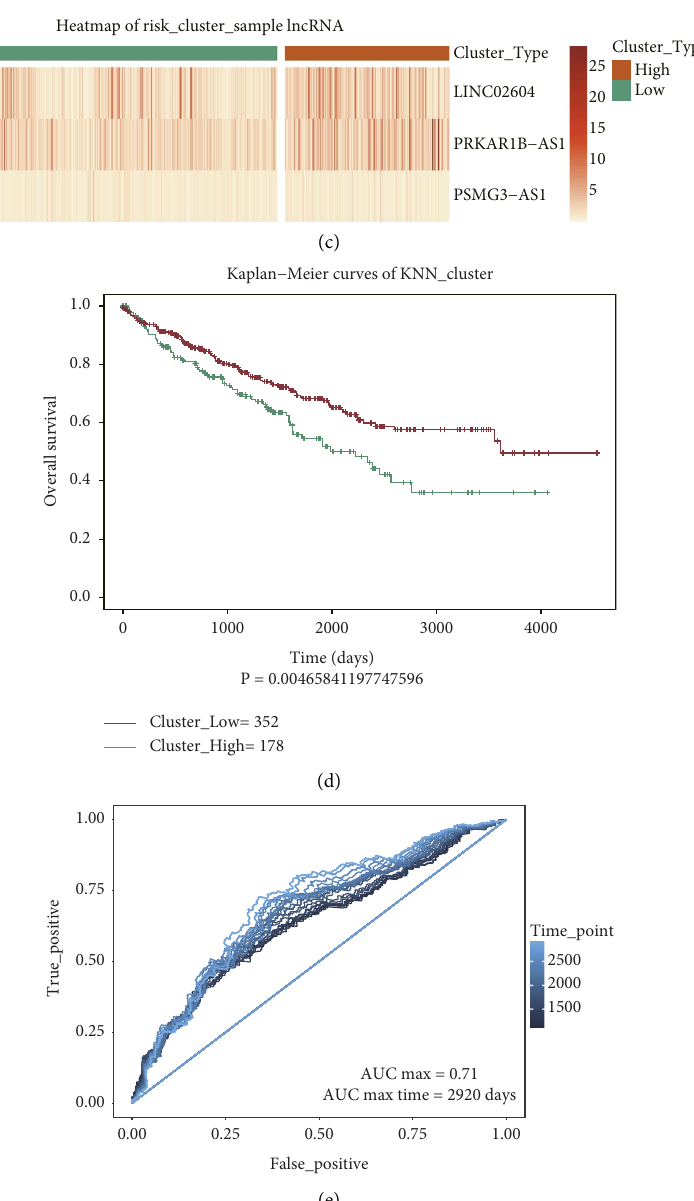
Figure 4: Construction and evaluation of the prognostic signatures. (a) Heat map of signatures. (b) KNN clustering-based scatter diagram. (c) Clustering analysis of signatures. (d) Survival analysis of the two types of samples after clustering. (e) Analysis of the classifcation efciency for